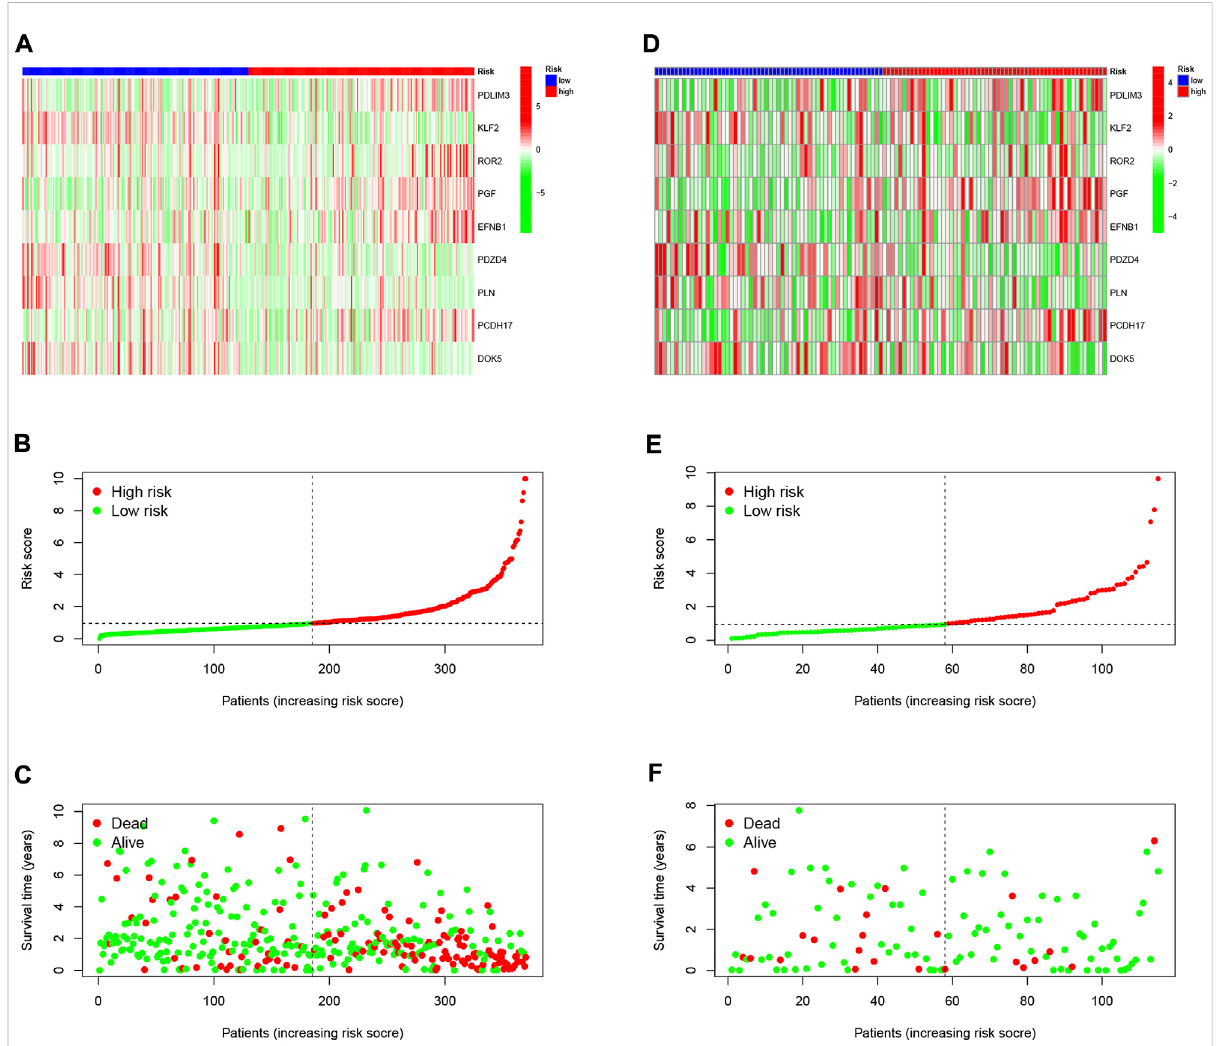
FIGURE 5 (A) Con fi rmationofprognosticriskscoresintheTCGAcohort. (B) PolygenicmodelriskscoredistributionintheTCGAcohort. (C) Survivalstatus and duration ofHCC patients in theTCGA cohort. (D) Con fi rmation of prognostic risk scores inthe GSE76427 cohort. (E) Polygenic model risk score distribution in the GSE76427 cohort. (F) Survival status and duration of LUAD patients in the GSE76427